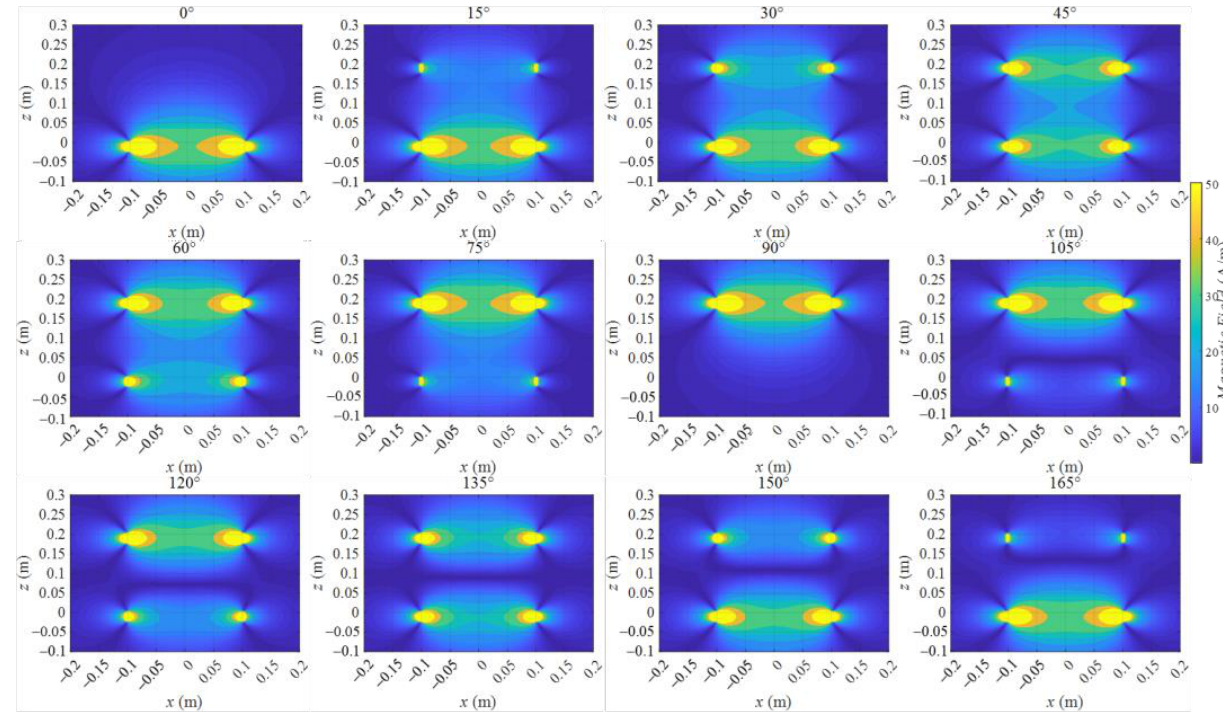
The magnetic field